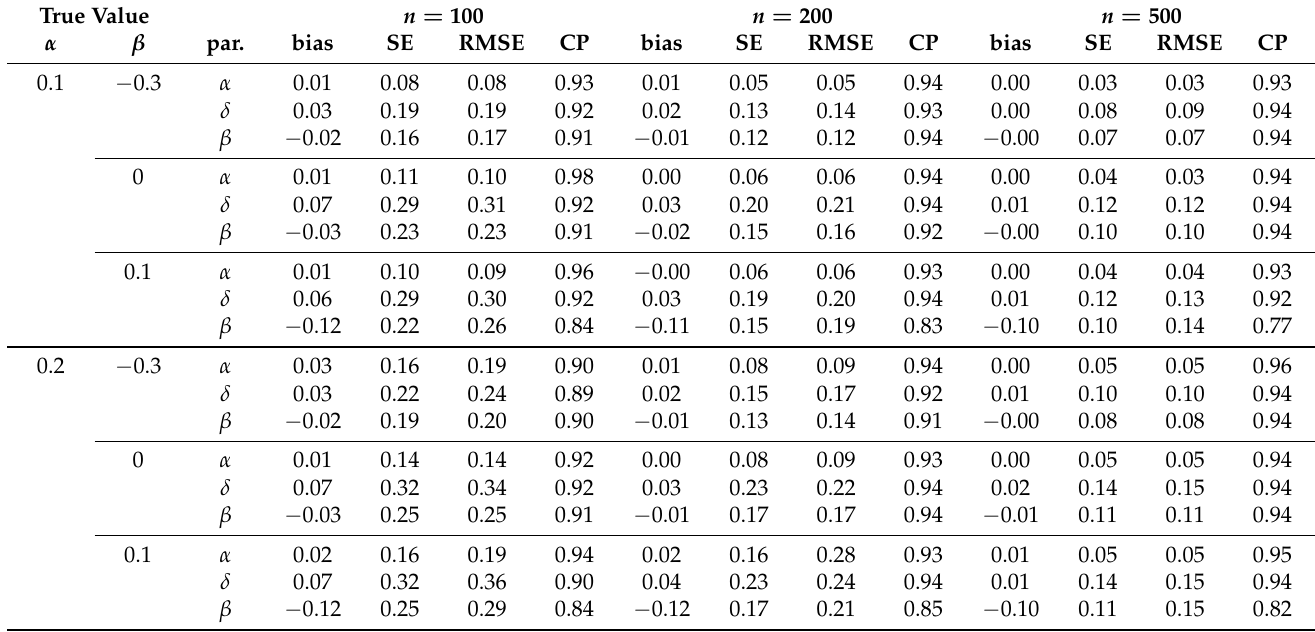
Table 3. Empirical bias, SE, RMSE and 95% CP for the ML estimates of α , δ and β in the EHPE distribution with different combinations of parameters (case true δ =